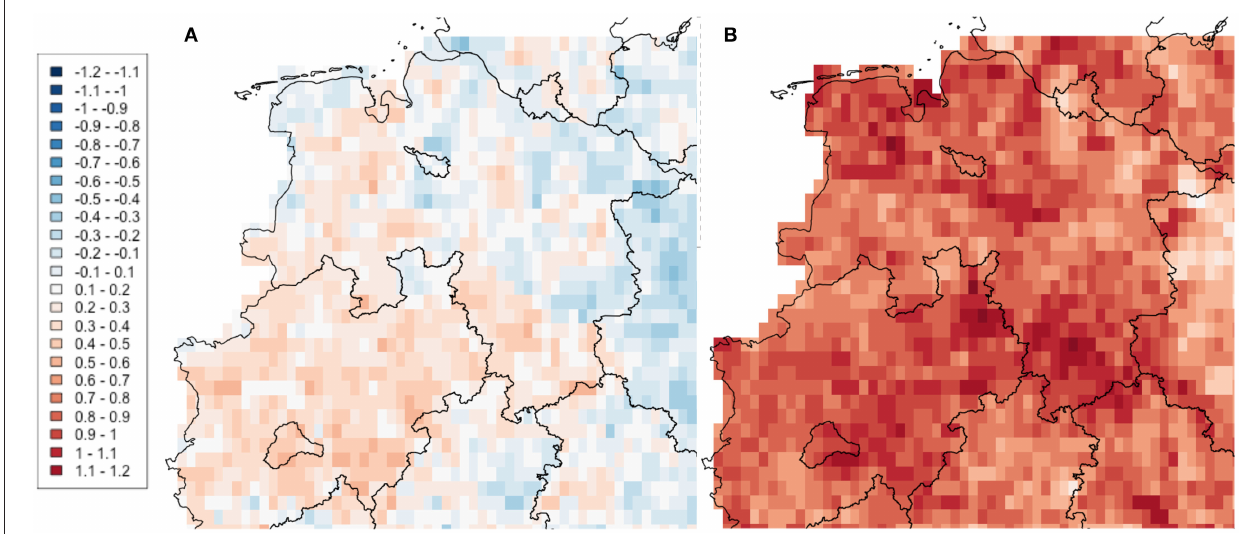
FIGURE 9 | Thresholds between the three categories of the decadal probabilistic prediction for 3-year SPI of January–December for forecast years 1–3, based on the 33% (A) and the 66% (B) terciles of observations in the reference period 1981–2010 (published on https://climate.copernicus.eu/sites/default/files/2021-09/ Technical_appendix_2020.pdf,